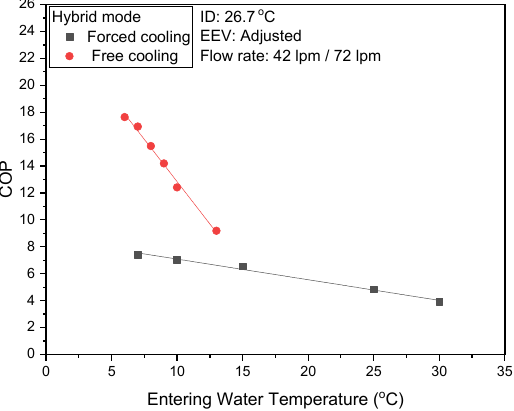
Figure 19. COP according to EWT in hybrid